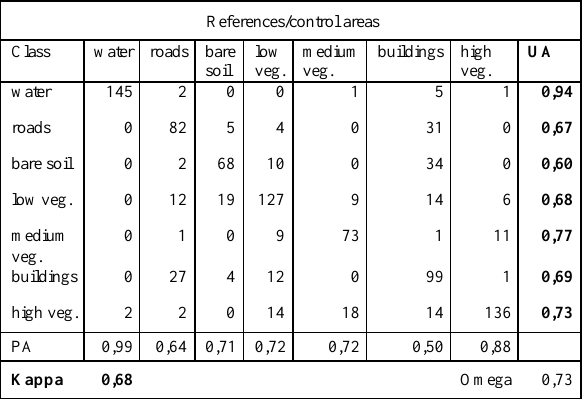
Table 3. Random Forests (200) classification results for “W” area The evaluation for grey infrastructure detection was performed for the aggregated classes as well. Overall accuracy for ML classification (table 4) was 87% for dense build-up area (“U”) and 92% for residential area (“W”). RF classification was also performed for “W” test site and resulted in a accuracy level of